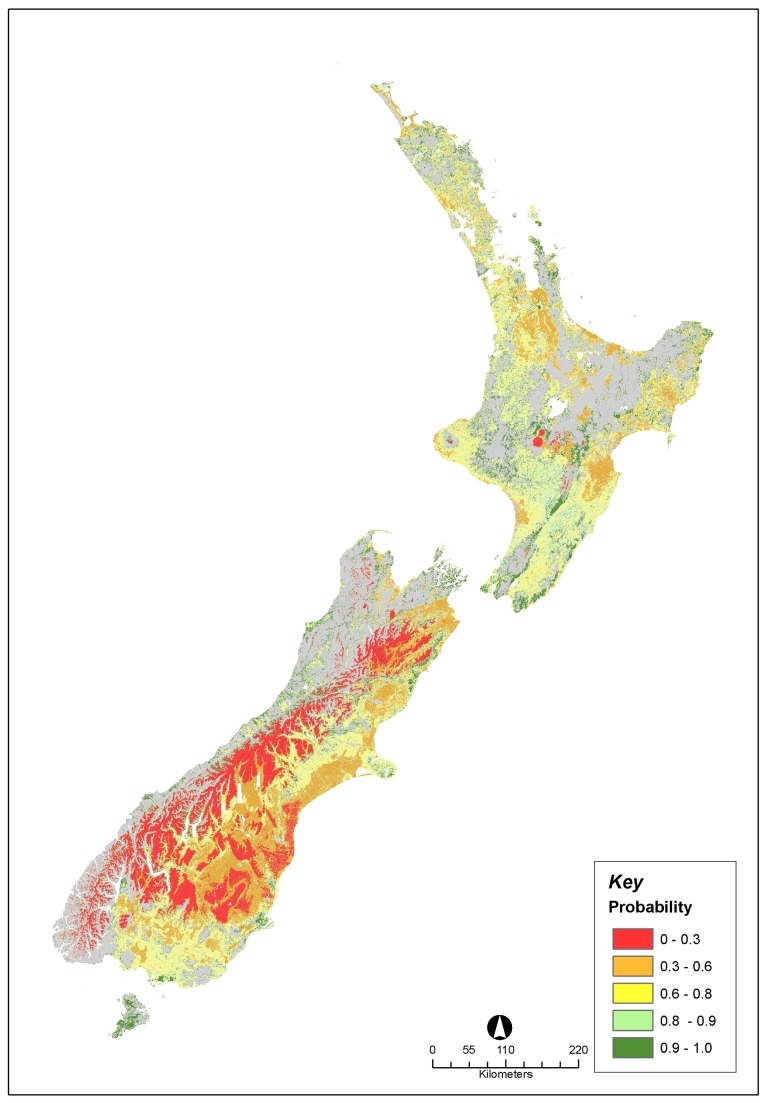
Map of predicted tree occurrence probability in non-forest vegetation in New Zealand.The map shows model-predicted probability of tree occurrence in non-forest vegetation (the ‘other’ and ‘subalpine scrub’ classes of Dymond and Shepherd [58]) in New Zealand. Grey areas are covered by indigenous (from [58]) and planted forest (from Land Cover Database 2).